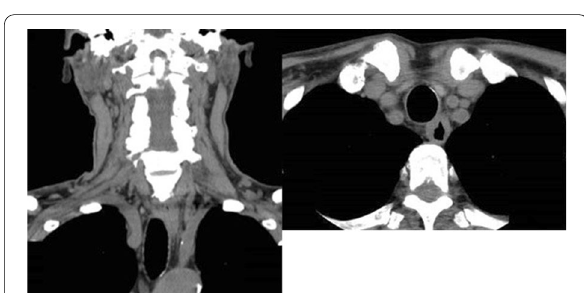
Fig. 5 Postoperative CT. There were no remaining